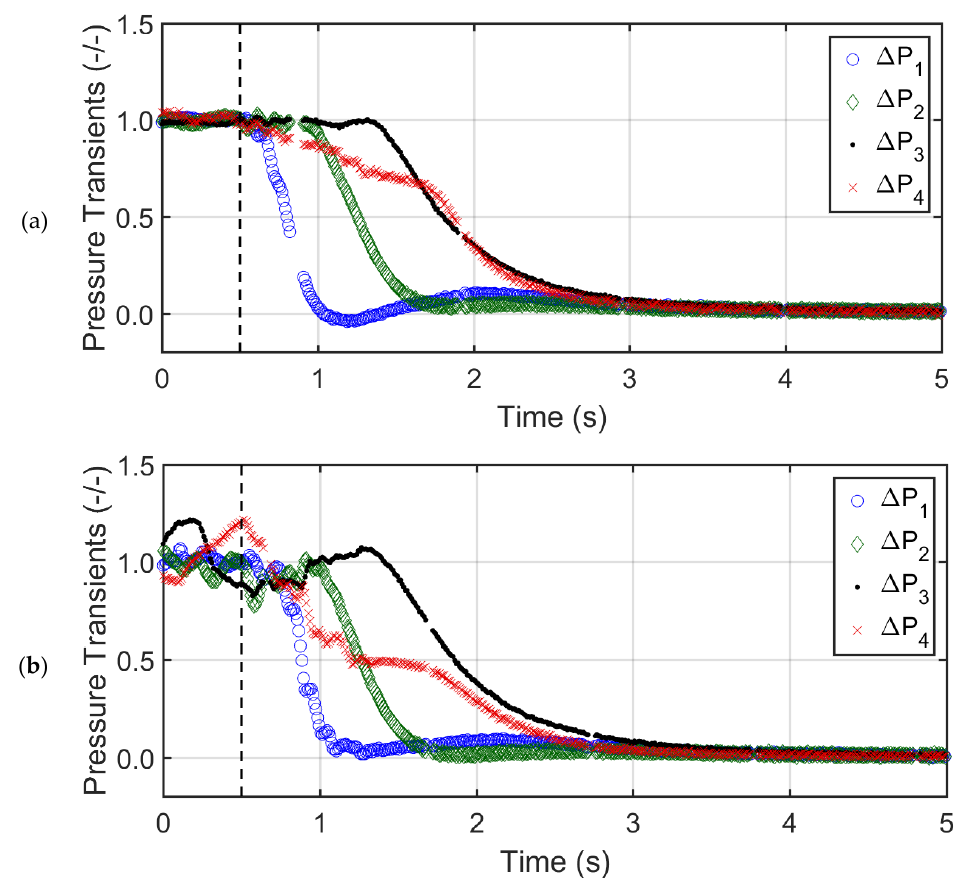
Figure 5. Pressure drop transients in different regions of the bed of glass beads for ( a ) 𝑈 0 = 𝑈 𝑚𝑓 , ( b ) 𝑈 0 = 2𝑈 𝑚𝑓 . Figure 6a,b report the pressure transients of the collapsing bed of titania powder at 𝑈 = 𝑈 𝑈 = 2𝑈 0 𝑚𝑓 and 0 𝑚𝑓 . The bubble escape time was significantly shorter (less than half) than that of the glass beads due to the smaller bubble concentration. The bubbling stage was observed only in ∆𝑃 3 transients with a bubbling time of approximately 0.3 s and 0.7 s for 𝑈 0 = 𝑈 𝑚𝑓 and 2𝑈 𝑚𝑓 , respectively. The ∆𝑃 3 region dominated the bed col- lapse process. The bubbling stage was not observed in the ∆𝑃 2 and ∆𝑃 4 transients, which could be attributed to the presence of cracks and channels in the upper and lower middle regions of the titania bed. Due to the poor contact between the gas and solid phases, the gas – solid drag and hence the pressure drop was low in the upper region of the bed during the collapse. As a result, the smaller agglomerates present in the upper middle layer mainly controlled the collapse process owing to size-based segregation. The size segrega- tion of the agglomerates along the bed height also affected the sedimentation stage tran- sients.